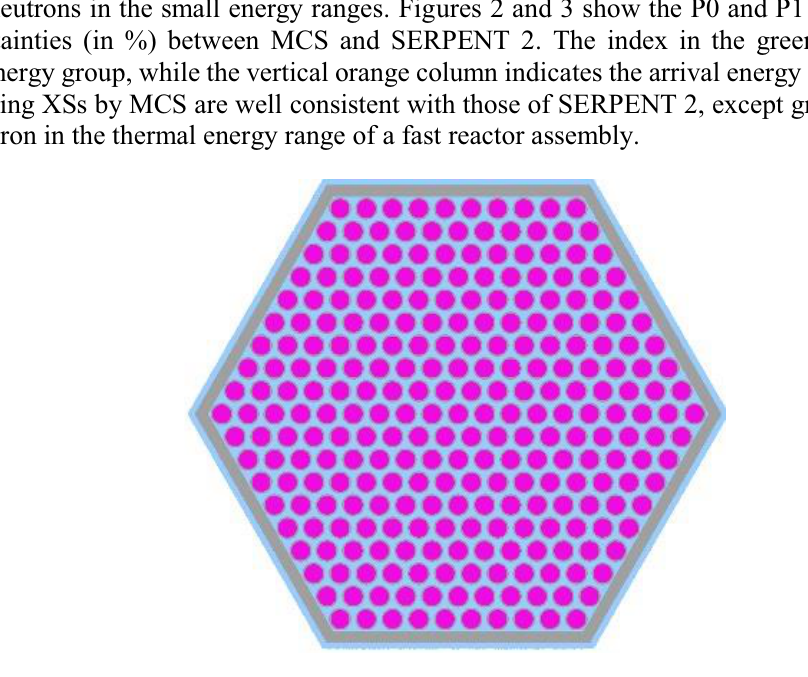
Figure 1. ABR-1000 Fuel Sub-Assembly Geometry [6]. Table III. Summary of 4-group flux and macro XSs (in: cm -1